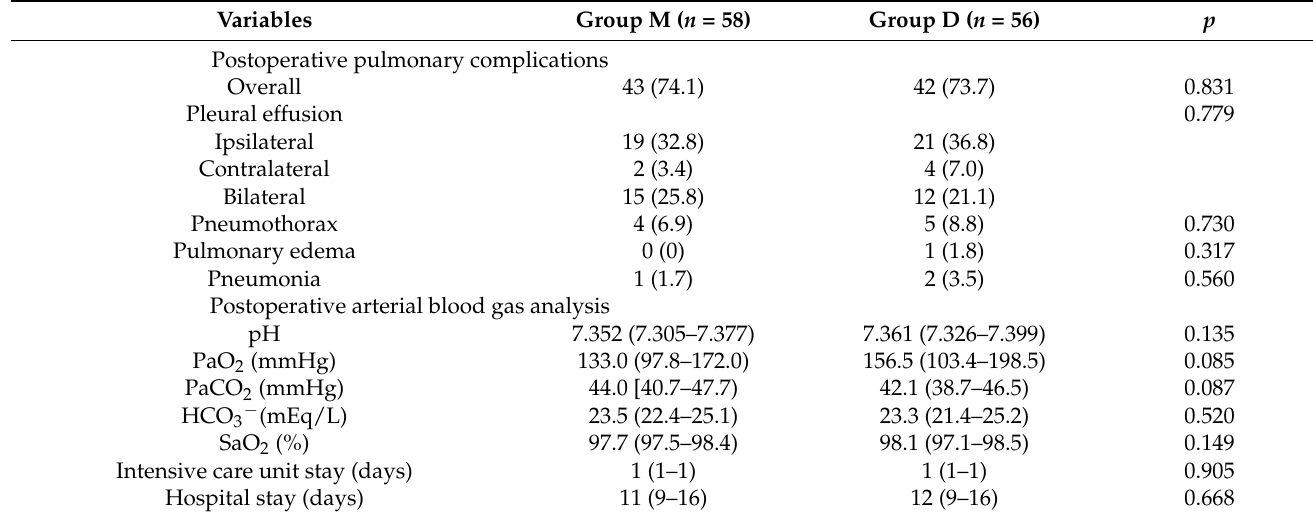
Table 3. Postoperative